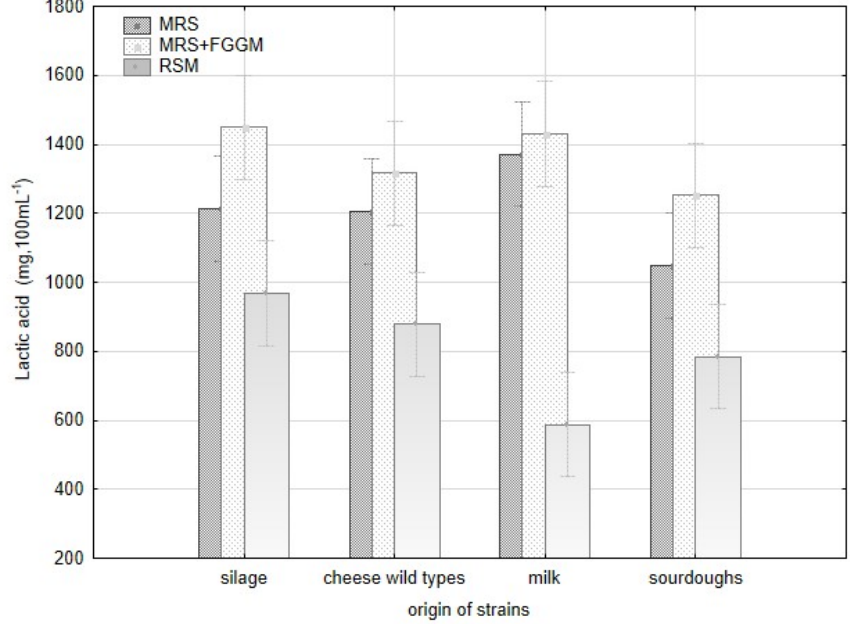
Figure A1. Modification of the pH value by L. plantarum strains with respect to strain origin and three cultivation media-MRS, MRS + FGGM and reconstituted milk.